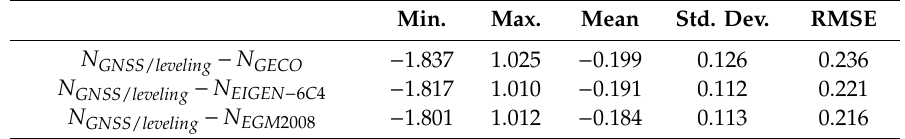
Figure 4. Residual surface maps between the GNSS/leveling-derived geoid heights (𝑁 𝐺𝑁𝑆𝑆/𝑙𝑒𝑣𝑒𝑙𝑖𝑛𝑔 ) on the 1182 UCPs and those (𝑁 𝐺𝐺𝑀 ) derived from the three GGMs. ( a ) GECO; ( b ) EIGEN-6C4; and ( c ) EGM2008. The red dots represent the locations of the 1182 GNSS/leveling UCPs. (cid:16) (cid:17) N GNSS / leveling Table 3. Statistics of the di ff erences between the geoid heights derived from the GNSS / leveling on the 1182 UCPs and those ( N GGM ) derived from the three GGMs (unit, m). Table 3. Statistics of the differences between the geoid heights (𝑁 𝐺𝑁𝑆𝑆/𝑙𝑒𝑣𝑒𝑙𝑖𝑛𝑔 ) derived from the GNSS/leveling on the 1182 UCPs and those (𝑁 𝐺𝐺𝑀 ) derived from the three GGMs (unit, m). Min. Max. Mean Std. Dev. RMSE Min. Max. Mean Std. Dev.